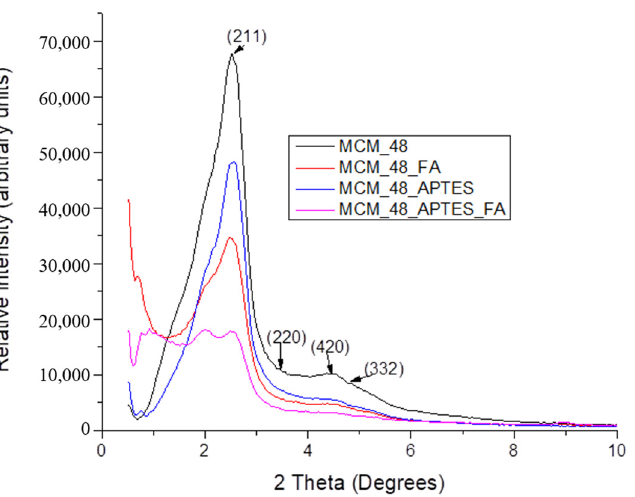
Figure 3. X-ray data for the MCM-48 based samples: MCM-48, MCM-48_FA, MCM-48_APTES and MCM-48_ APTES _FA.